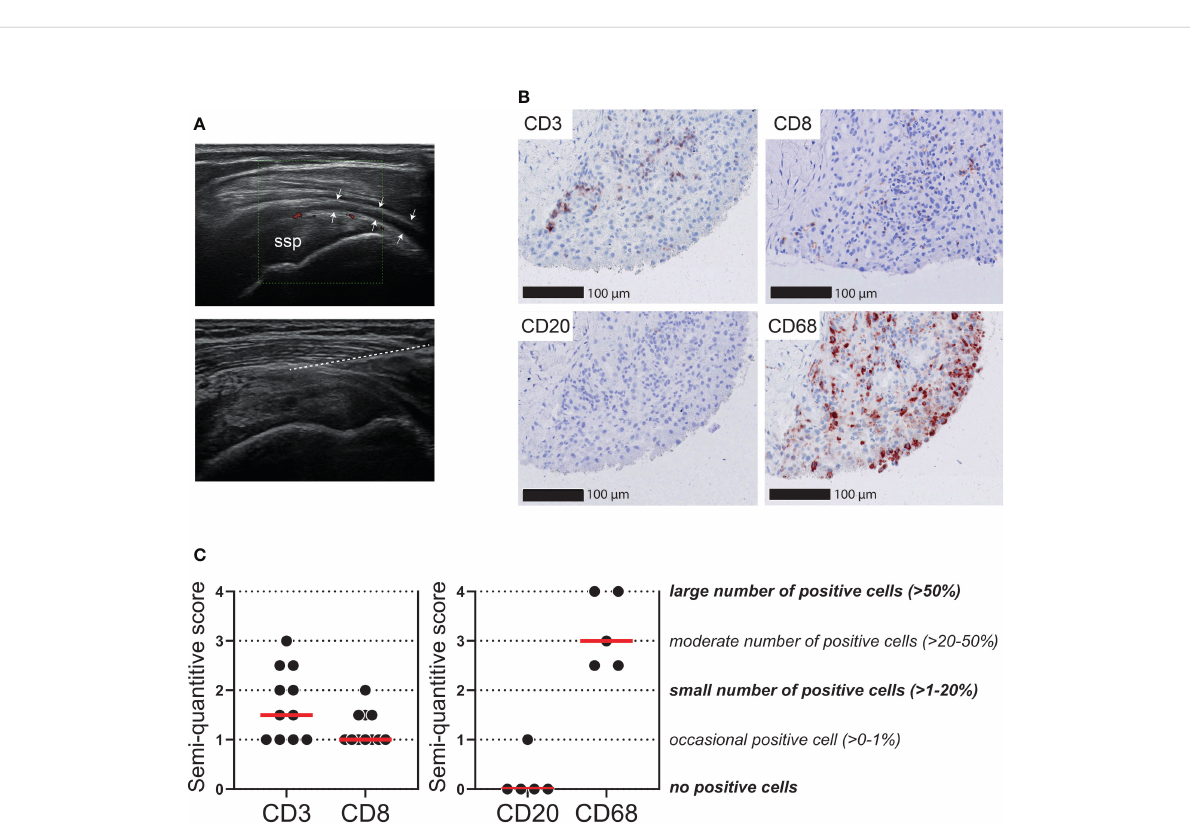
FIGURE 5 T cells in the bursa tissue of patients with PMR. Ultrasound-guided biopsies were obtained from the subacromial-subdeltoid (SASD) bursa of patients with PMR. (A) Representative ultrasound image (left panel) of in fl amed SASD bursa (arrow heads), and trajectory of core biopsy needle (right panel) highlighted by the dashed line (B) Representative immunohistochemistry staining for CD3, CD8, CD20 (B cells) and CD68 (macrophages) in the synovial biopsy of a patient with PMR. (C) Semi-quantitative scoring for CD3 and CD8 in SASD bursa biopsies of 11 PMR patients (left panel), as well as CD20 and CD68 in 5 PMR patients (right panel). Scores of two independent investigators were averaged.